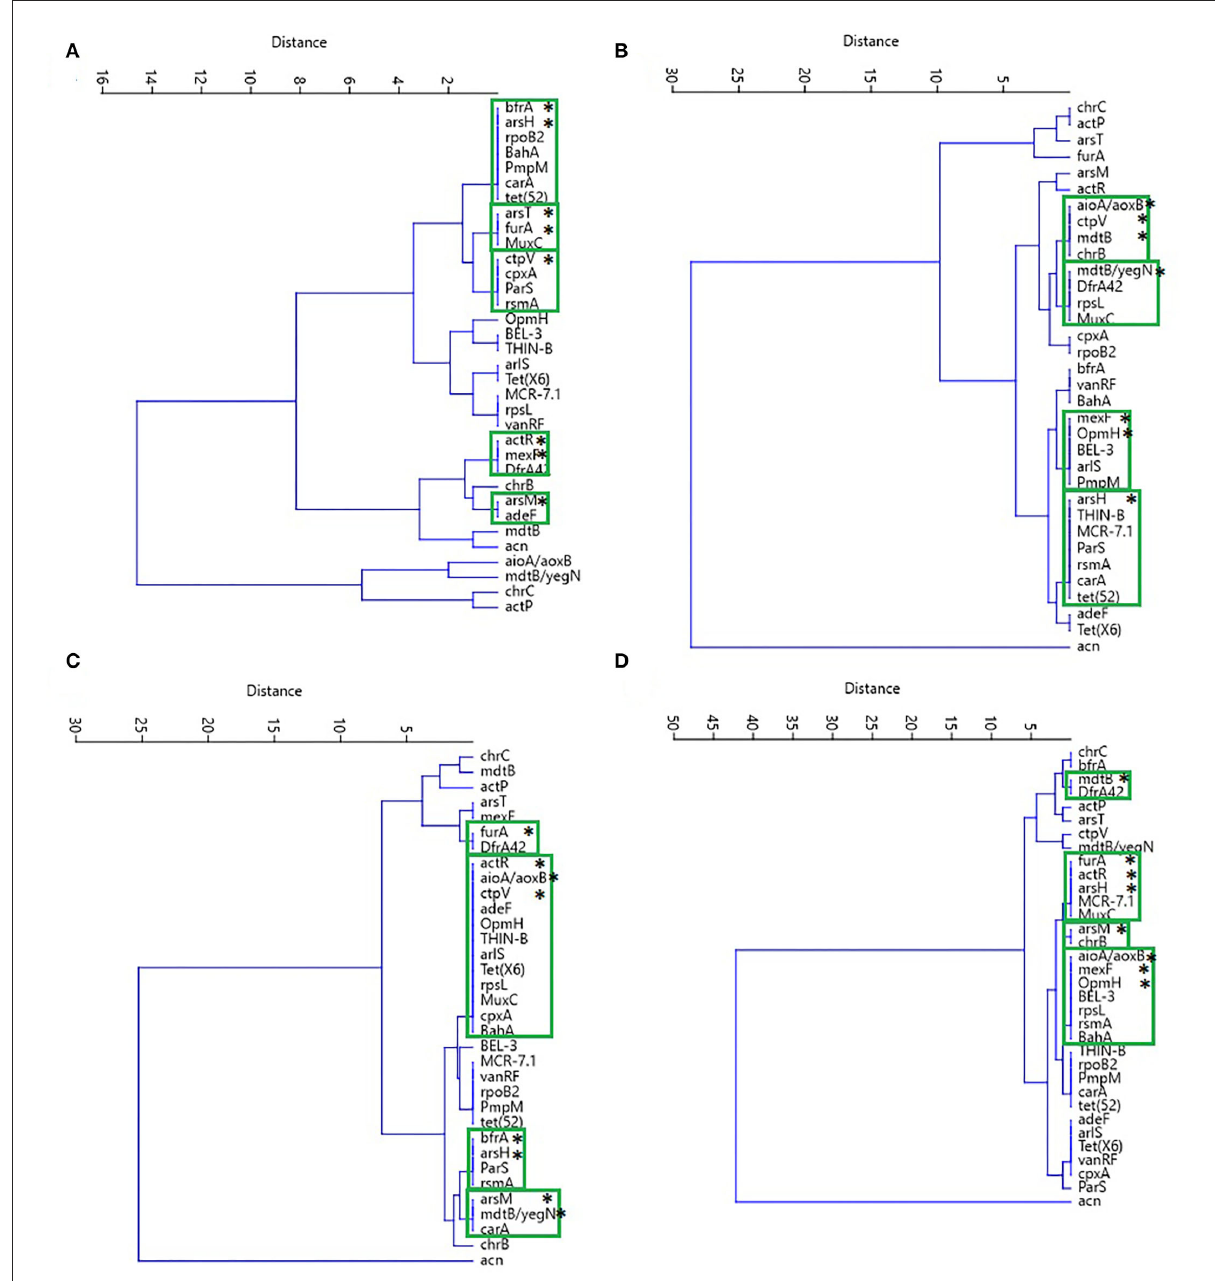
FIGURE9 Cluster analysis performed by the UPGMA algorithm and the Euclidean similarity index of the most abundant resistance genes to antibiotics and biocides and the characteristics analyzed in soils from (A) forest, (B) pasture, (C) 2-years crop, and (D) culture of 14 years. In the green boxes are grouped the genes of resistance to antibiotics and biocides